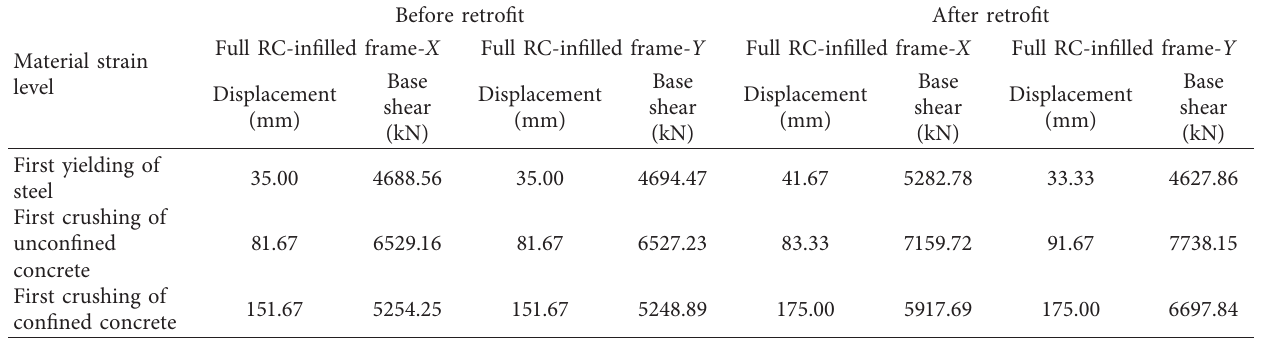
Table 8: Material strain level of the full RC-infilled frame.